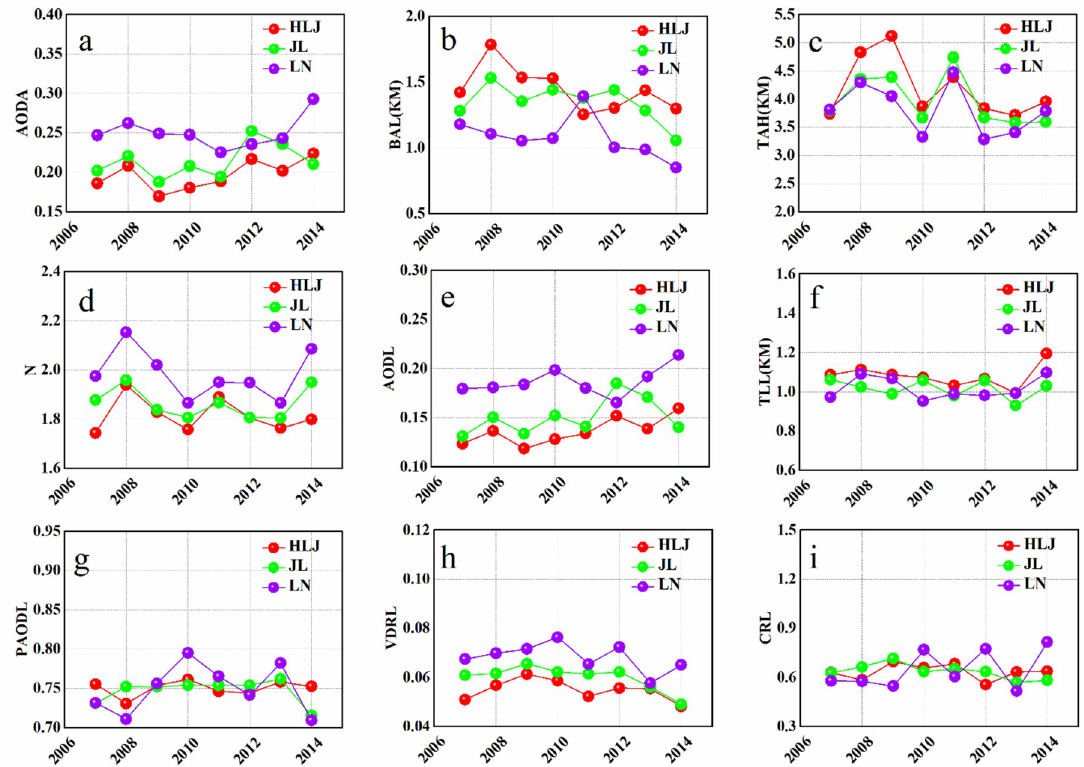
Figure 3. Inter-annual variations in the optical and physical properties of aerosol layers over NEC (HLJ, JL, and LN) in the nighttime from 2007 to 2014. ( a ) AODA, ( b ) BAL, ( c ) TAH, ( d ) N, ( e ) AODL, ( f ) TLL, ( g ) PAODL, ( h ) VDRL, and ( i ) CRL.